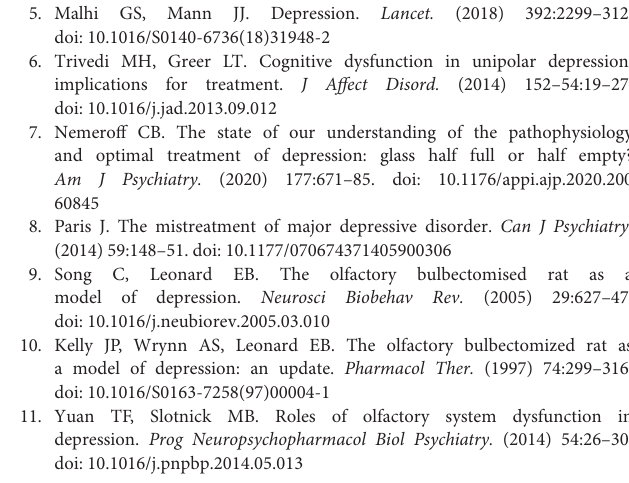
Supplementary Figure 1 | Representative image of the lateral septal nucleus VOI template, used as a reference region for the SUVr normalization (A) . Representative images of the total hippocampus (B) and subregions, dorsal (C) and ventral (D) VOI templates. Representative images of the hippocampal positive (metabolism increase) percentage of change between group Sham Sal baseline and groups Sham GUO, OBX Sal, and OBX GUO, in the baseline scan (E) . Representative images of the hippocampal positive (metabolism increase) percentage of change between group Sham Sal baseline and groups Sham Sal, Sham GUO, OBX Sal, and OBX GUO, in the follow-up scan (F) . T-statistical maps showing the statistically significant increased metabolism in the hippocampal region on groups Sham GUO, OBX Sal, and OBX GUO, in the follow-up scan, in comparison with the group Sham Sal follow-up (G) . Representative images of the hippocampal positive (metabolism increase) percentage of change between group Sham Sal follow-up and groups Sham Sal, Sham GUO, OBX Sal, and OBX GUO, in the follow-up scan (H)